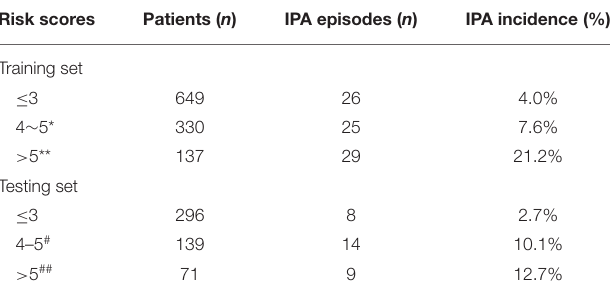
TABLE 4 | Distribution of risk scores vs. the cumulative incidence of IPA in the training and testing datasets.